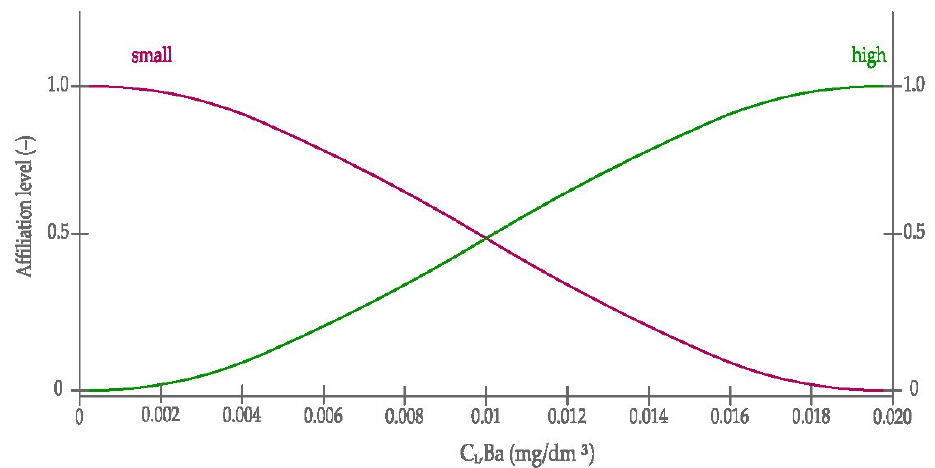
Figure 13. The sigmoid curves used in modelling Ba leaching from opoka rock. C 1, Ba—leachability of Ba.